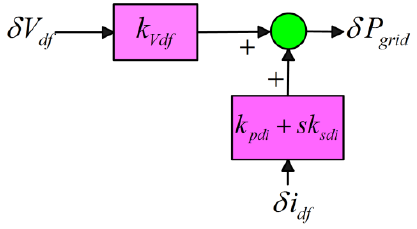
Figure 7. Small-signal block diagram of injected power into the grid.